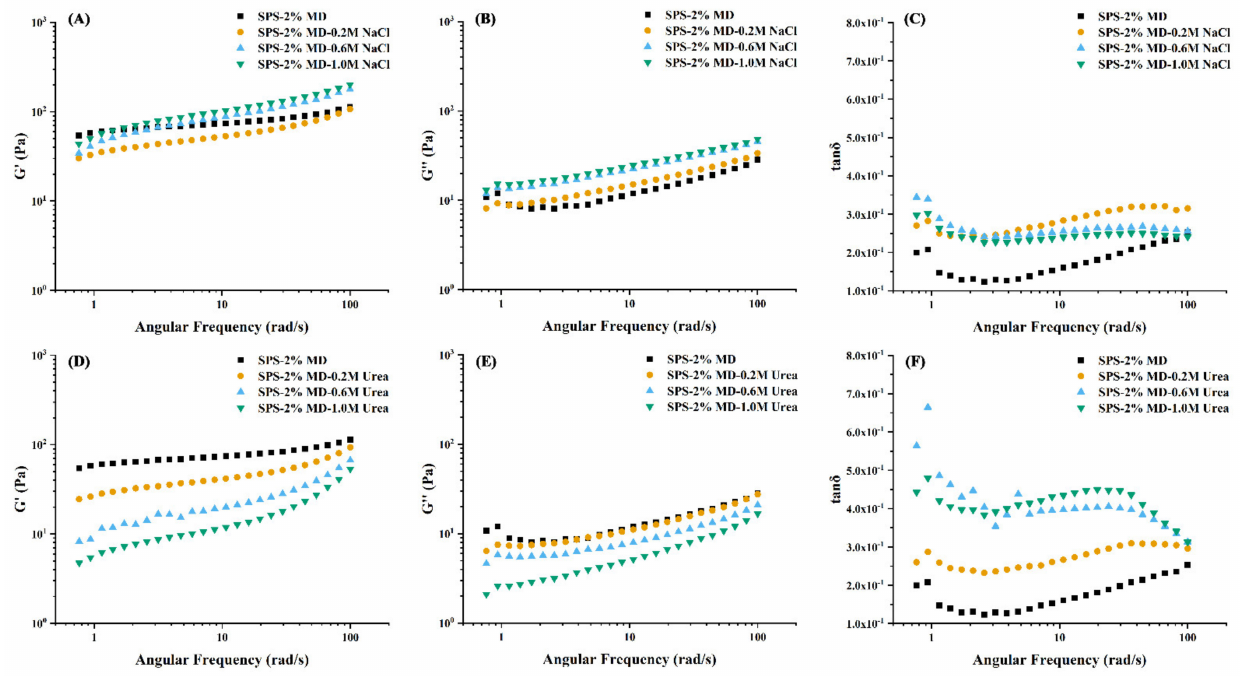
Figure 4. The storage ( G (cid:48) ) and loss ( G” ) modulus, and tan ( δ ) curves of sweet potato starch (SPS) gels with 2% ( w / w ) maltodextrin (SPS − 2% MD) under different concentrations of NaCl ( A – C ) and urea ( D – F ).